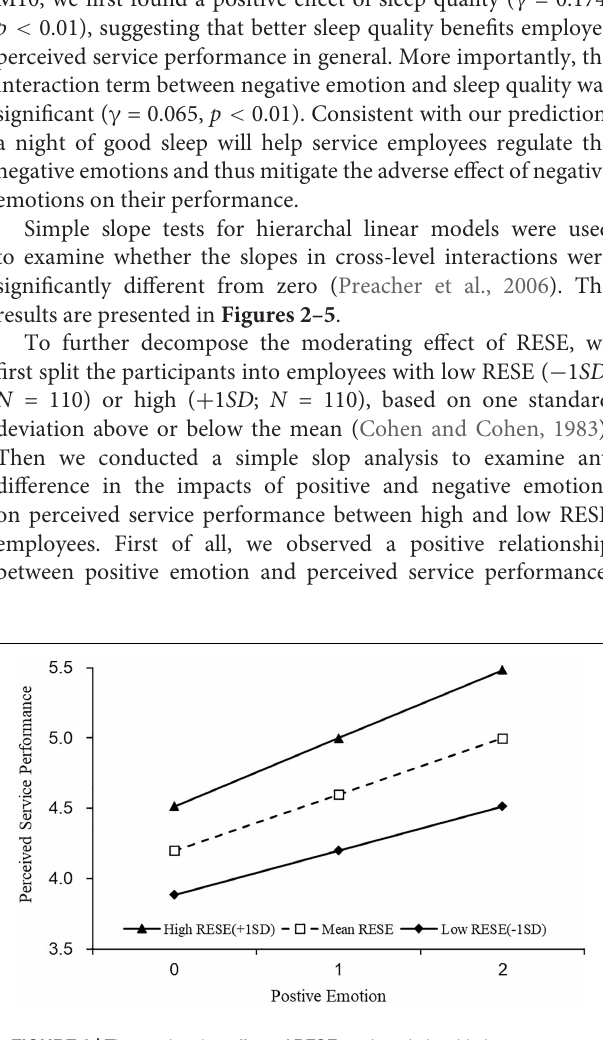
FIGURE 2 | The moderating effect of RESE on the relationship between positive emotions and perceived service performance.